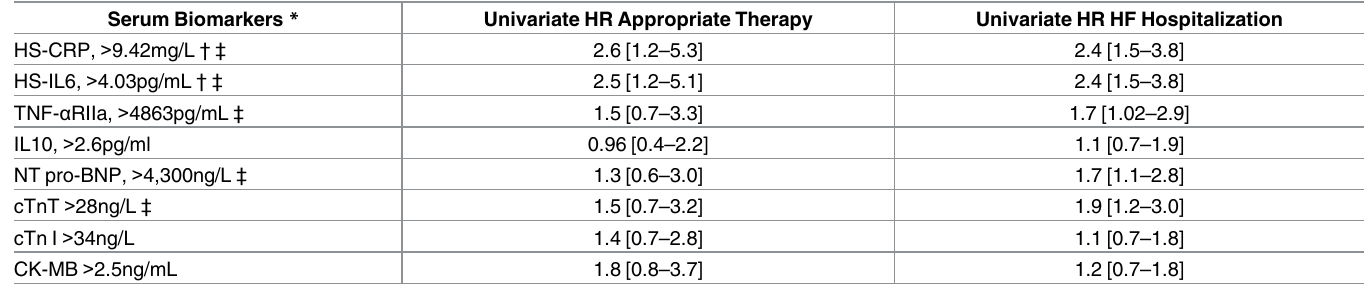
Table 3. Unadjusted hazard ratios [HR] for appropriate therapy and HF hospitalization–serum biomarkers. Serum Biomarkers